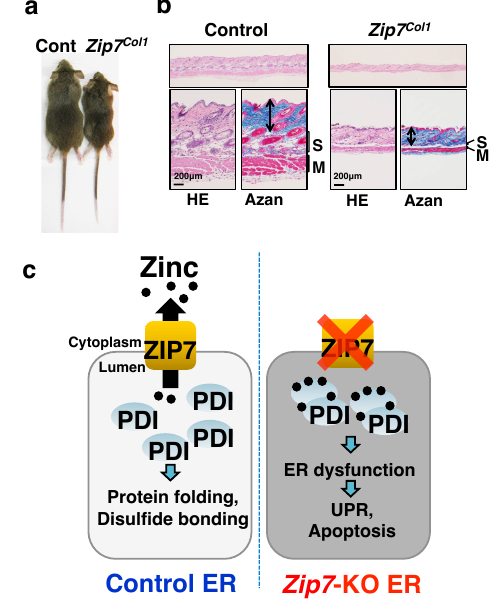
Figure 5. ZIP7 is essential for dermis formation. ( a ) Five-week-old female wild-type (WT) and Zip7 Col1 mice. ( b ) The thickness of the Azan-stained Zip7 Col1 dermis is reduced. M, muscle; S, Subcutis. ( c ) Models for the involvement of ZIP7 in ER function. When ZIP7 is dysregulated (right), the luminal zinc level is elevated, which would induce zinc-dependent aggregation of PDIs. Therefore, protein folding and disulfide bond formation would proceed aberrantly, leading to unfolded protein responses. ER, endoplasmic reticulum; KO, knockout; PDI, protein disulfide isomerase; UPR, unfolded protein response. Modified from Bin et al.